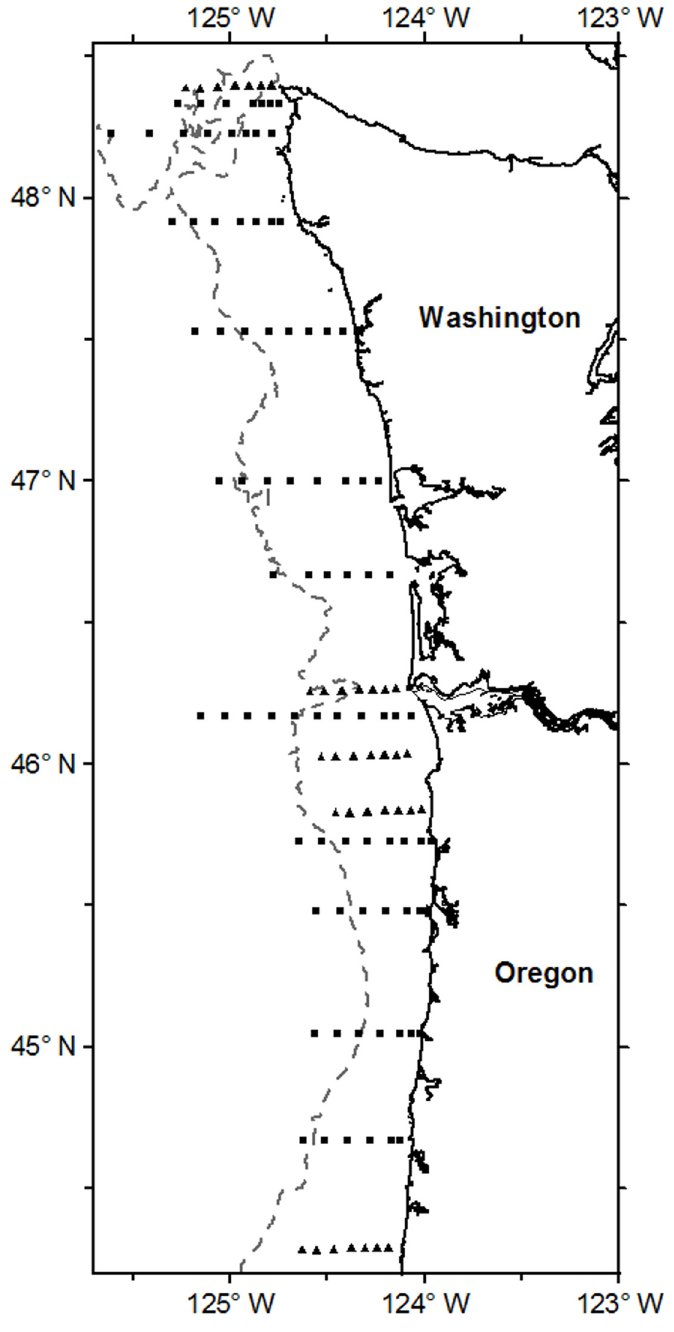
Fig 1. Ocean sampling stations along the Oregon and Washington coast for juvenile Chinook salmon. Map with general station locations off the coast of Oregon and Washington in the USA where juvenile salmon were sampled in 1981 – 1985 from OSU study as triangles and 1998 – 2011 during the Plume Study as squares. North-South dashed line reflects the 200 m isobaths line. Map created using Surfer 1 - Golden Software,